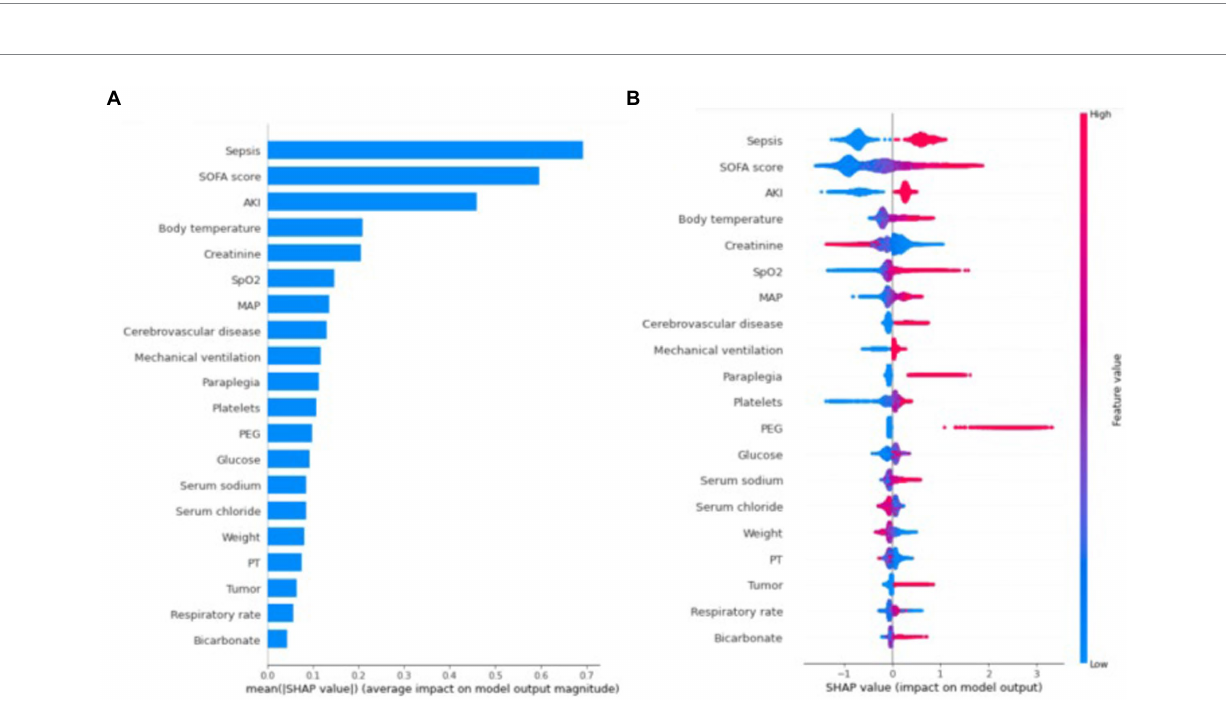
FIGURE 2 The ROC curves of six models.